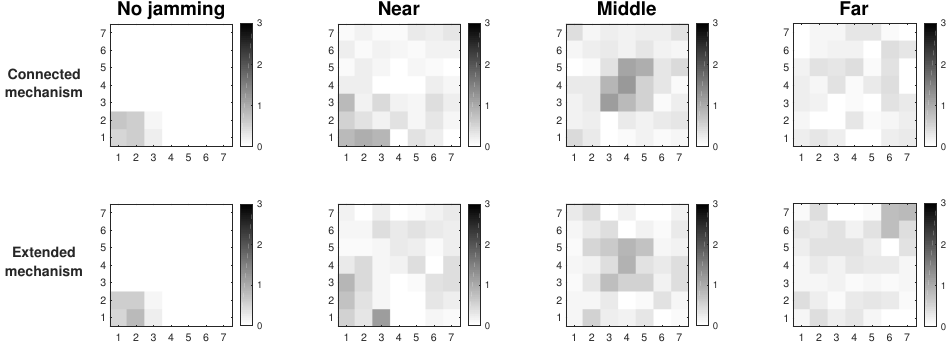
Figure 4. Connected vs extended mode under maximum packet